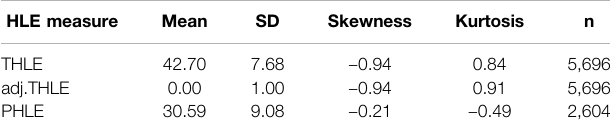
TABLE 5 | Descriptive statistics of the toddler home learning environment (THLE), child age-adjusted toddler home learning environment (adj.THLE) and preschool home learning environment (PHLE)